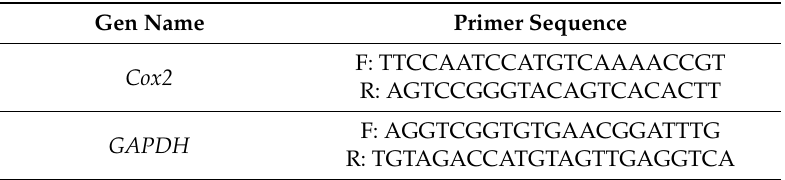
Table 1. RT-qPCR primers used in this